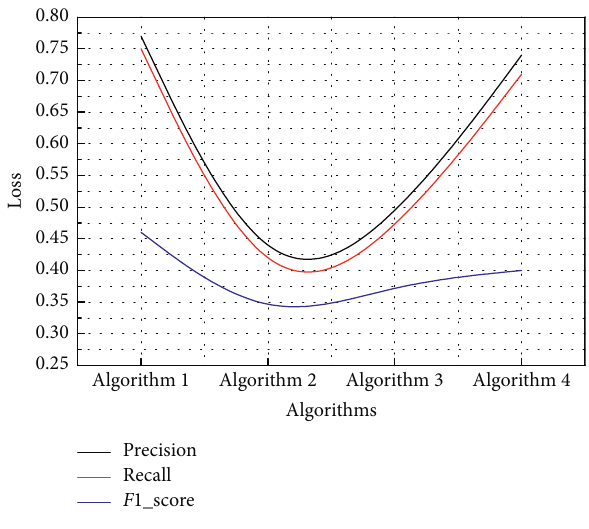
Figure 5: Performance comparison chart.